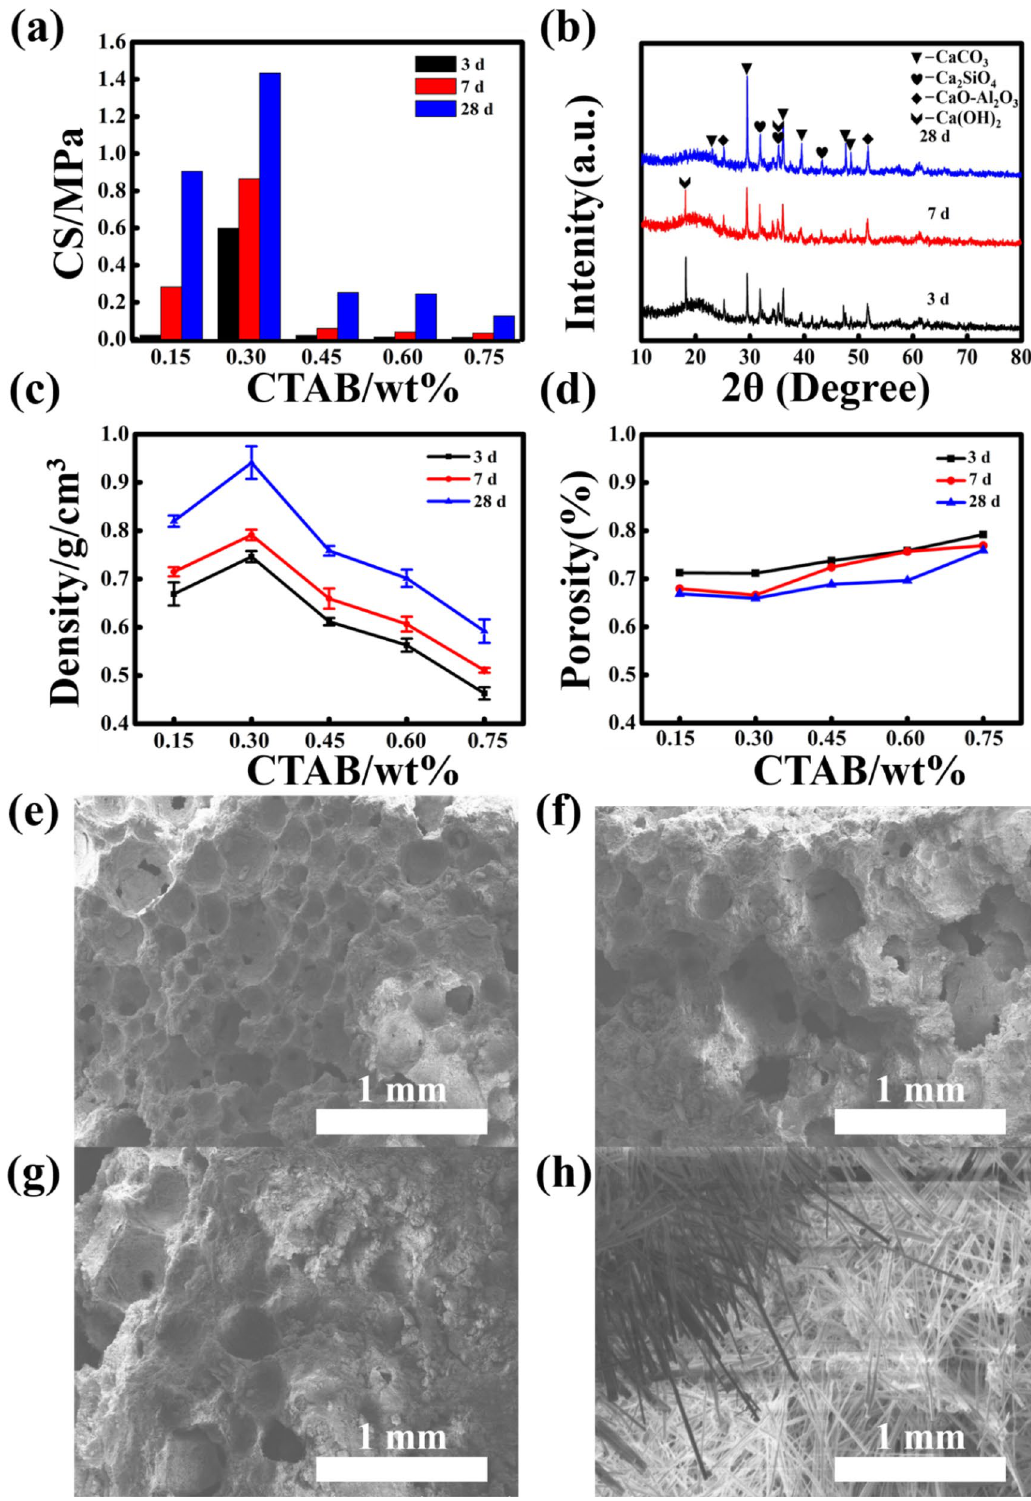
Figure 4. Properties and microstructure of expansive materials with different doses of CTAB. ( a ) compressive strength, ( b ) XRD pattern of C-2 cured for 3 d, 7 d, 28 d, ( c ) density, ( d ) porosity, ( e , f , g , h ) SEM images of C-2 cured for 3 d, 7 d, 28 d and the microgram of group C-2 cured for 28